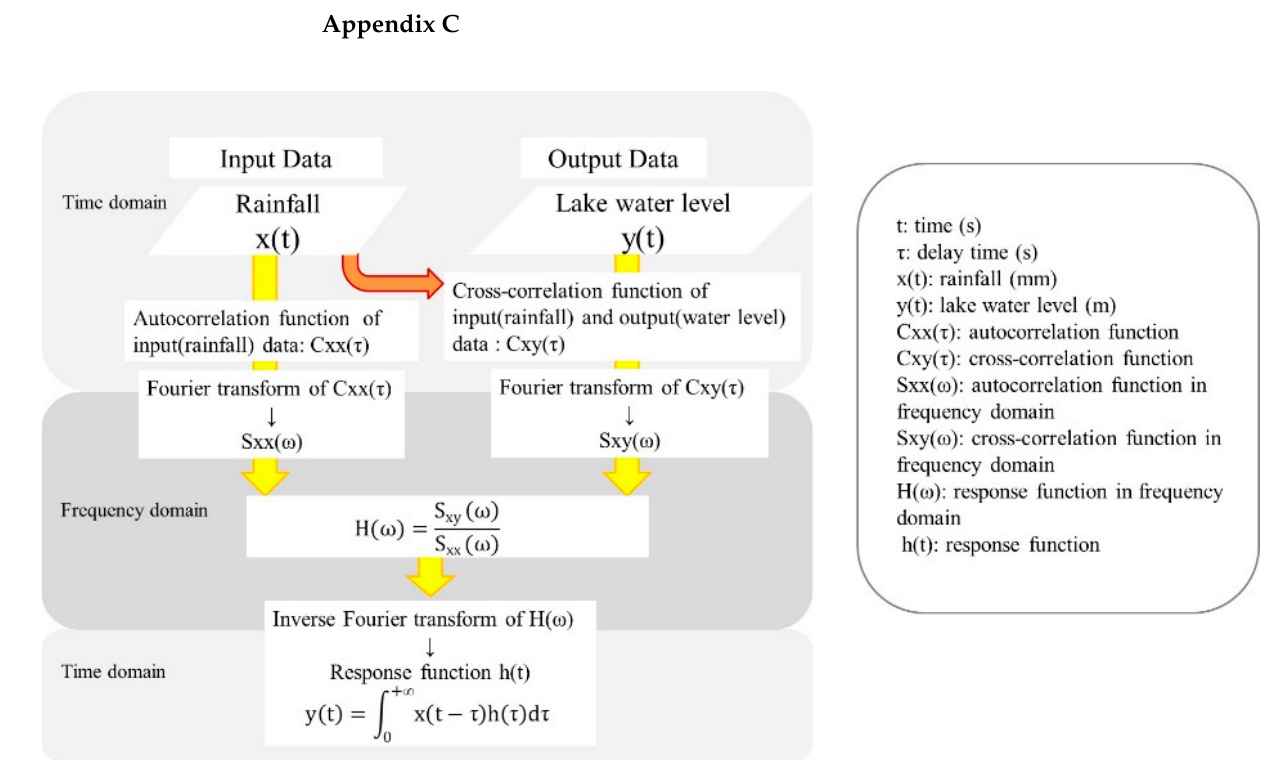
Figure A1. Time series comparison of the observed data obtained using a depth metre near the surface (5 and 10 m) of the lake and water level data of MLIT.